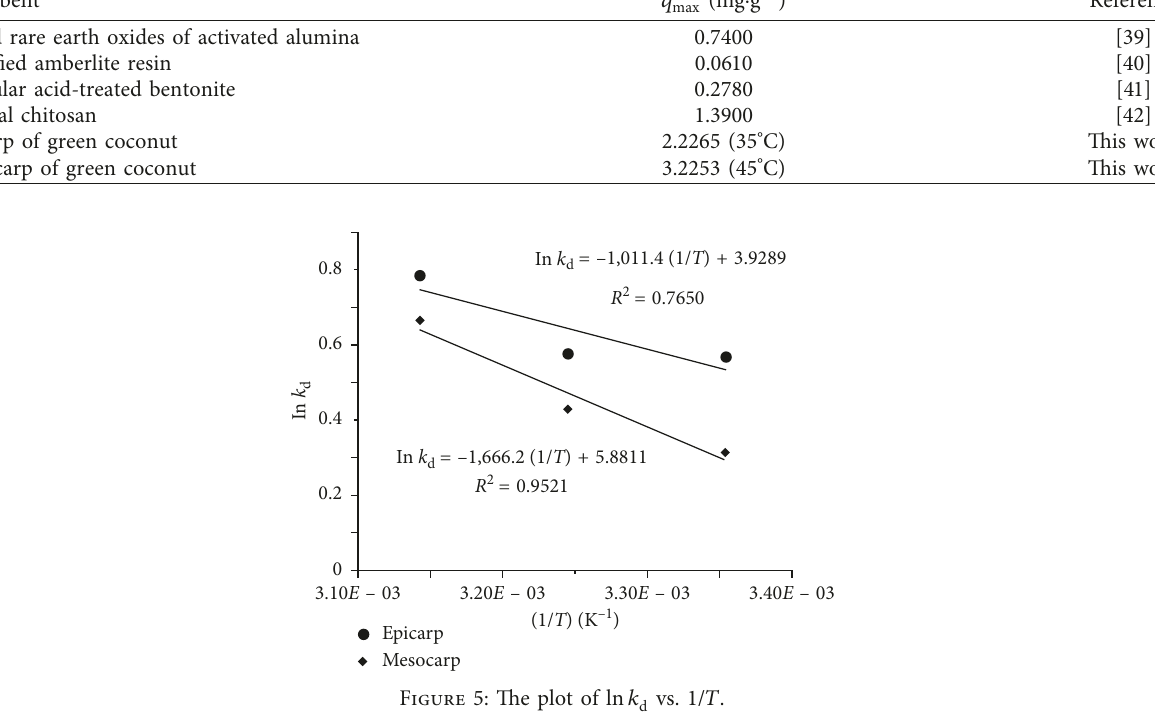
Table 5: Thermodynamic parameters for adsorption of fluoride ions on epicarp and mesocarp of green coconut. T ( °